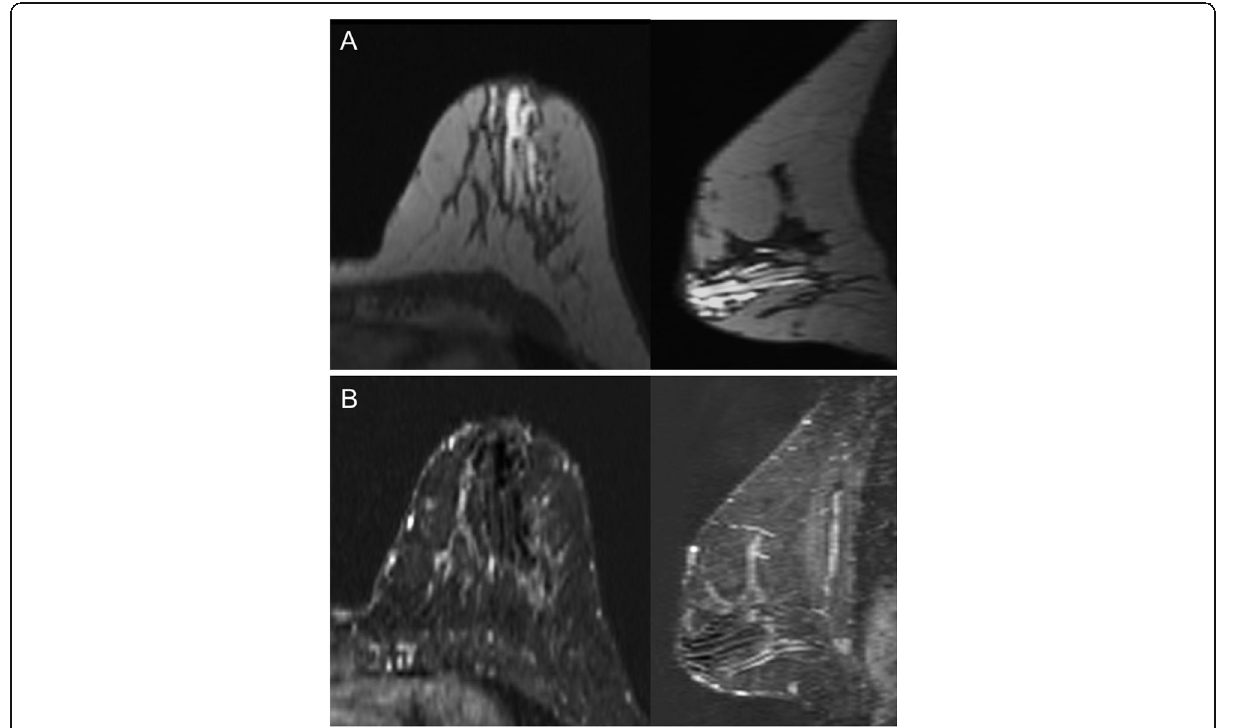
Fig. 20 Ectasia and MRI. Screening MRI in an asymptomatic high-risk 38-year woman 6 months after lactation. a Unenhanced axial and sagittal T1-weighted images. b Contrast-enhanced axial and sagittal T1-weighted MRI (subtracted image obtained 120 s after contrast injection). Note the tubular structures in the retroareolar region of the left breast with a segmental distribution; proteinaceous material causes increased signal intensity on T1-weighted sequences, but not intraductal